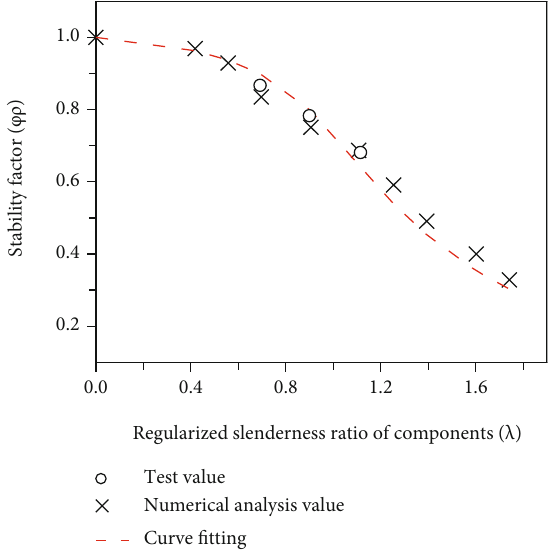
Figure 13: Relationship between regular slenderness ratio and stability coe ffi cient.